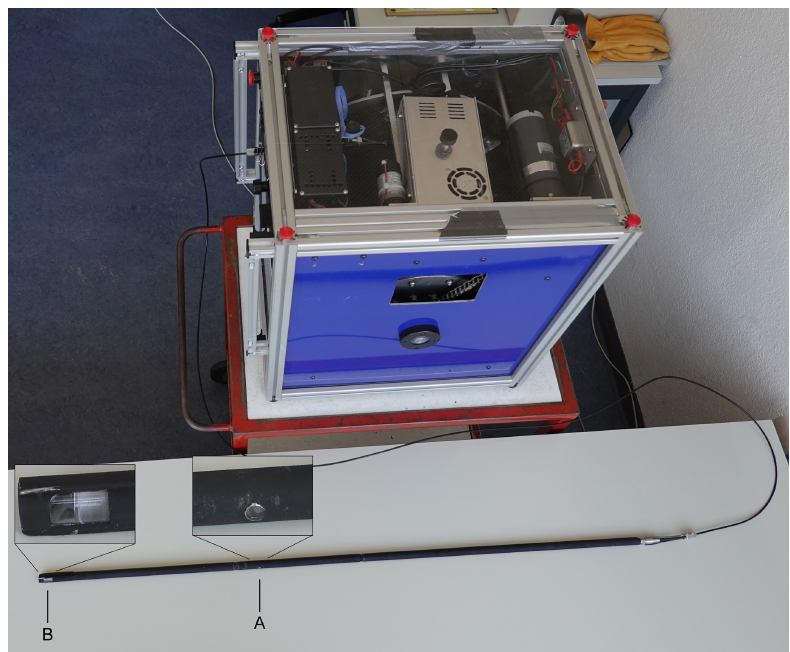
Figure 11. Logger and 3.5mm fiber-optic cable winch: A marks the emitting 405nm LED; B marks the receiving window and